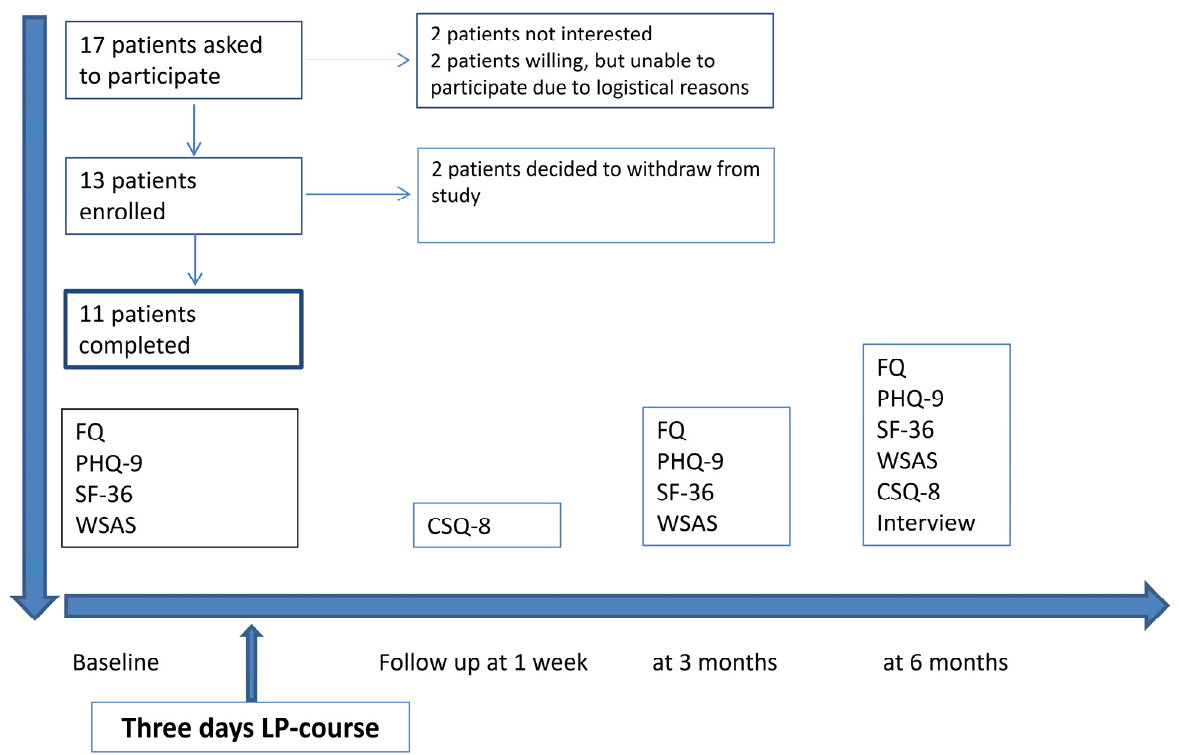
Figure 1. Flow Chart Patients and Study Outline. Adherence to study and timeline related to intervention, patient-reported outcome measures (PROMs) and interview. Fatigue Questionnaire (FQ), Patient Health Questionnaire 9 (PHQ-9), Short-Form Health Survey 36 (SF-36), Work and Social Adjustment Scale (WSAS) and Client Satisfaction 8 (CSQ-8).